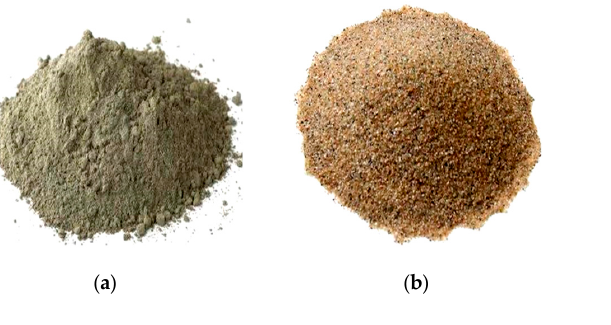
Figure 3. ( a ) commercial cement, ( b ) river sand, ( c ) natural coarse aggregates (NCA)—10 mm, ( d ) natural coarse aggregates (NCA)—20 mm.